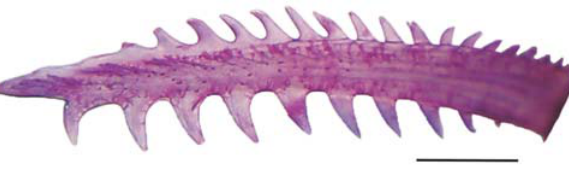
Fig. 2 . Left pectoral spine of Microglanis carlae (CZCEN 313, río Paraguay, Limpio, Central). Scale bar = 1 mm.